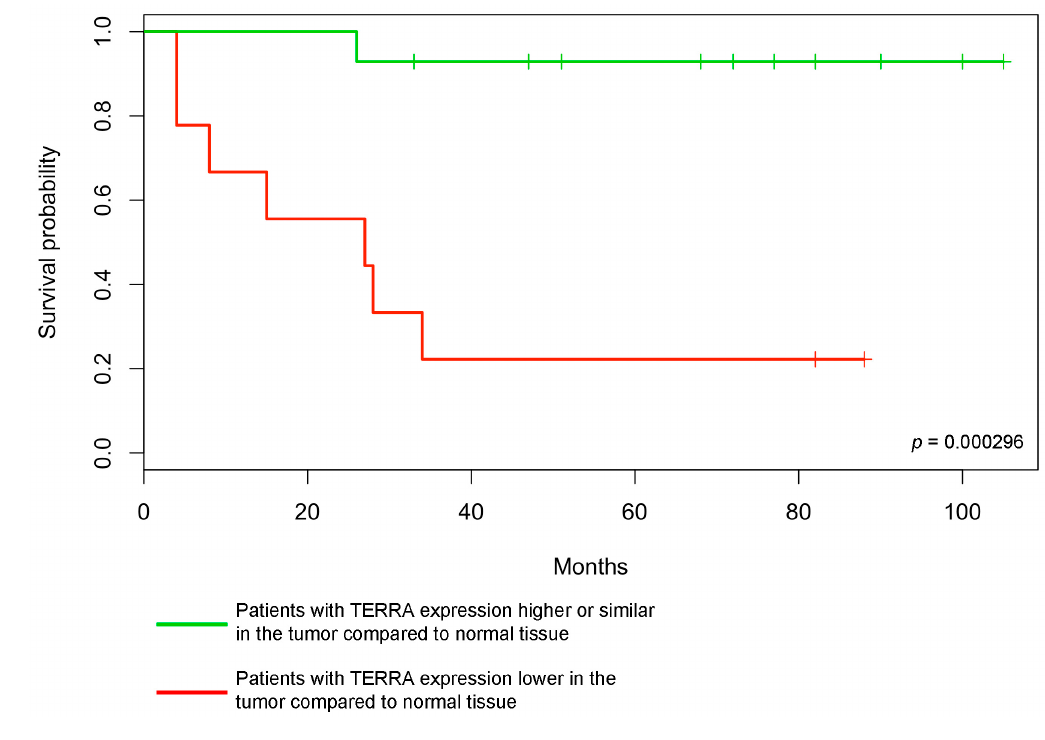
Figure 3. Disease free survival of 23 HNSCC patients. The probability of disease free survival, in months, in the two classes of patients is shown. Patients with TERRA expression higher or similar in the tumor compared to normal tissue (green curve), patients with TERRA expression lower in the tumor compared to normal tissue (red curve). The p -value of the log-rank test for the statistical significance of the difference between the two curves is shown.